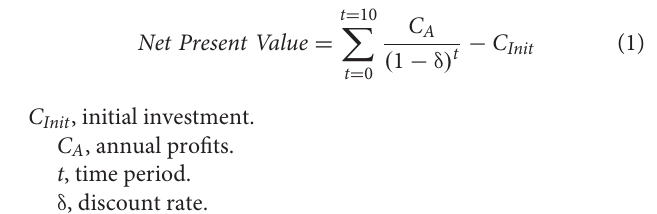
be the most stable in terms of production and profit ( Figure 2C